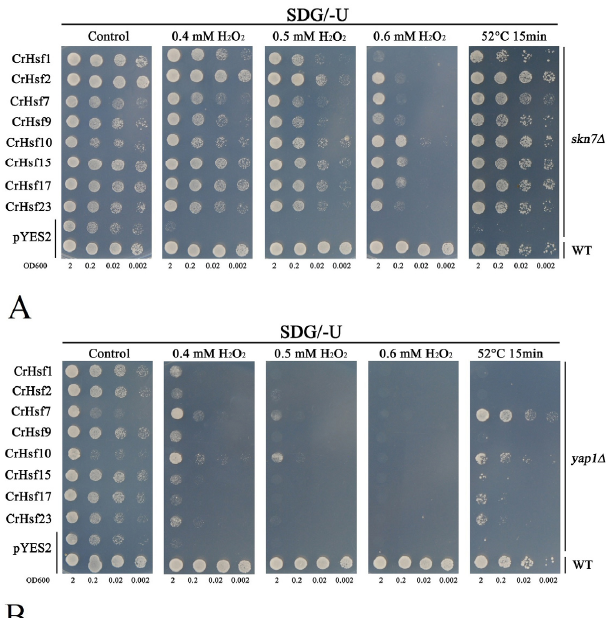
Figure 11. The tolerance confirmations of the eight CrHsf gene heteroexpression in yeast. H 2 O 2 oxi- dative stress and heat stress (52 °C 15 min) tolerance confirmations in yeast mutant strain skn7 ∆ ( A ) and yap1 ∆ ( B ). The stress factors with different concentrations are shown in the figures. Yeast cul- tures were adjusted to OD600 = 2, and 2 μ L of serial dilutions (10-fold, from left to right in each panel) was spotted on SDG/-Ura medium supplemented with different concentrations of H 2 O 2 (0.4 mM, 0.5 mM, and 0.6 mM), and small portions of the yeast cultures were incubated at 52 °C for 15 min, and then were moved to a 30 °C environment before being spotted on SDG/-Ura medium (without any chemical stress factors) for the thermotolerance confirmation. Corresponding yeast spots growing on SDG/-Ura plates without H 2 O 2 or heat stress were used as the control. The plates were incubated for 2–5 days at 30 °C. The images are representative of three independent experi- ments.